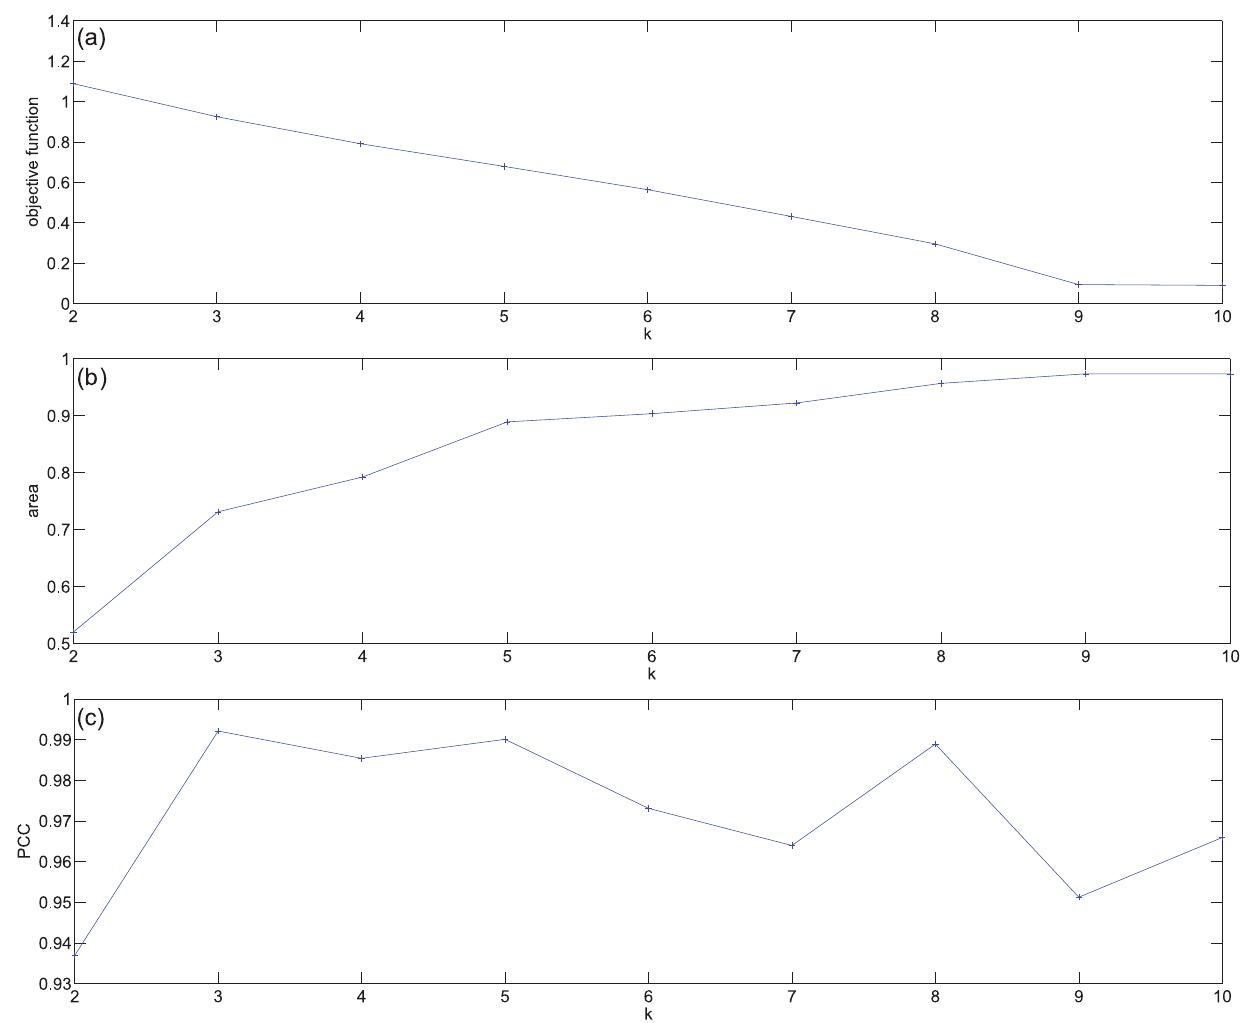
Figure 4. Three measures of the performance versus specified cluster size, k , when the four tissue types are factorised separately. (a) The value of the objective function for k ~ 2, ... ,10 . (b) The area under consensus cumulative density function for k ~ 2, ... ,10 , [3,14]. (c) The cophenetic correlation coefficient, [3].